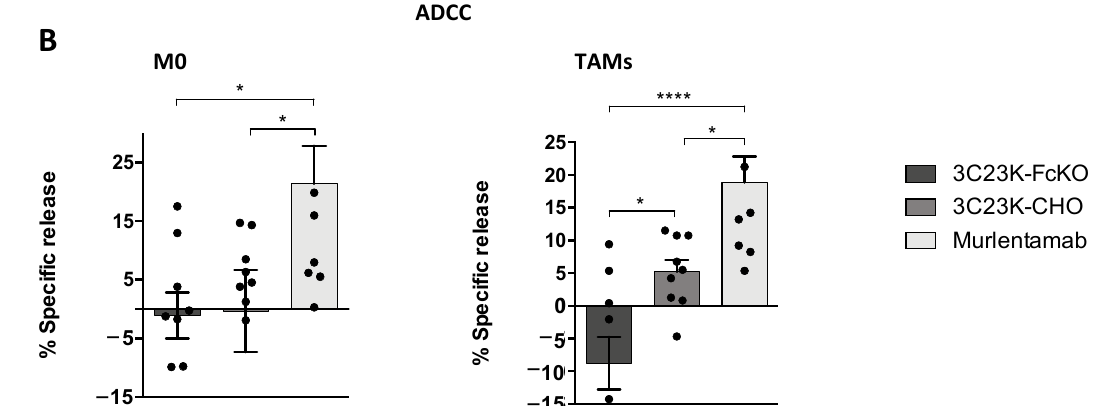
Figure 2. Murlentamab opsonization of SKOV3-R2 + increases macrophage anti-tumoral activity and antibody-dependent cell-mediated cytotoxicity (ADCC) killing. SKOV3-R2 + ovarian tumor cells were labeled with different 3C23K antibodies (3C23K-FcKO control, 3C23K-CHO normally fucosylated or murlentamab the low fucosylated form) and cultured in the presence of human monocyte-derived macrophages from healthy donors unstimulated (M0) or stimulated with M-CSF and IL-10 (tumor-associated macrophages (TAMs)). ( A ) Opsonized-SKOV3-R2 + cell number was determined by flow cytometry after one and two days of co-culture with M0 or TAMs. * p < 0.05; ** p < 0.01 compared 3C23K-FcKO vs. murlentamab at a given time ( B ) ADCC was performed after 4 h of co-culture between SKOV3-R2 + cells and M0 or TAMs. Data shown (mean ± SEM) are the results from three different experiments (performed with three different healthy donors). * p < 0.05; **** p < 0.0001. p values were determined using one-way ANOVA analysis followed by Tukey’s multiple comparisons test.